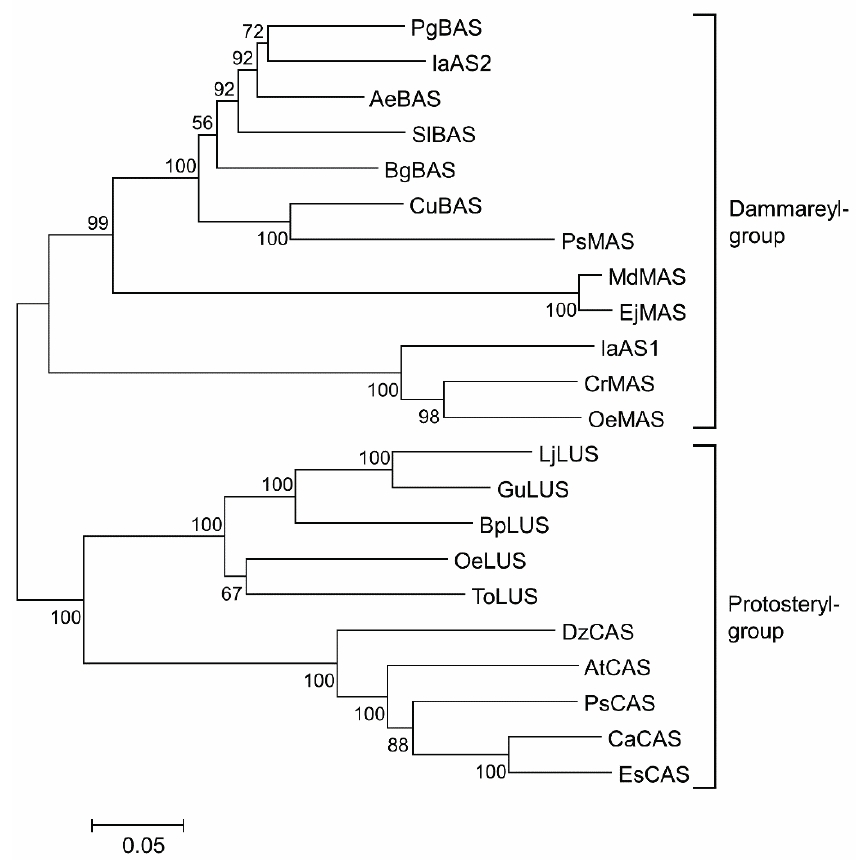
Figure 8. Bootstrapped neighbour-joining tree of known OSCs. The tree was constructed by MEGA 5.1 software using the neighbour-joining method, with an evaluation method